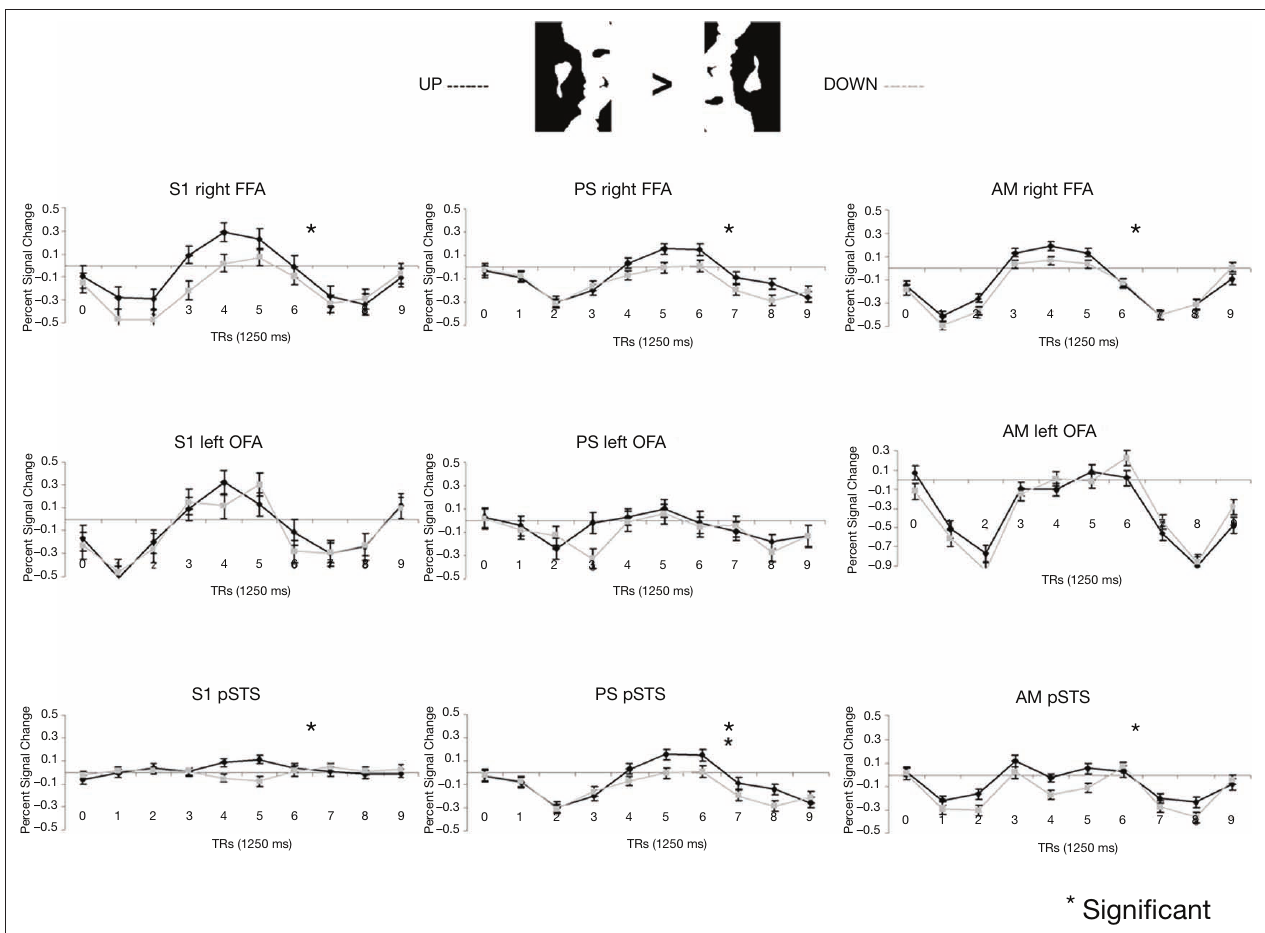
Figure 5 | Among the face-sensitive areas that are intact in the prosopagnosic patient’s brain, only the right FFA, and the pSTS to a lesser extent, present a larger response to Mooney stimuli perceived as faces as compared to the same pictures presented upside-down (“non-faces”). Similar findings are made control participants (S1 illustrated), PS and the age-matched control (AM). The left OFA does not show any enhanced response to the Mooney face